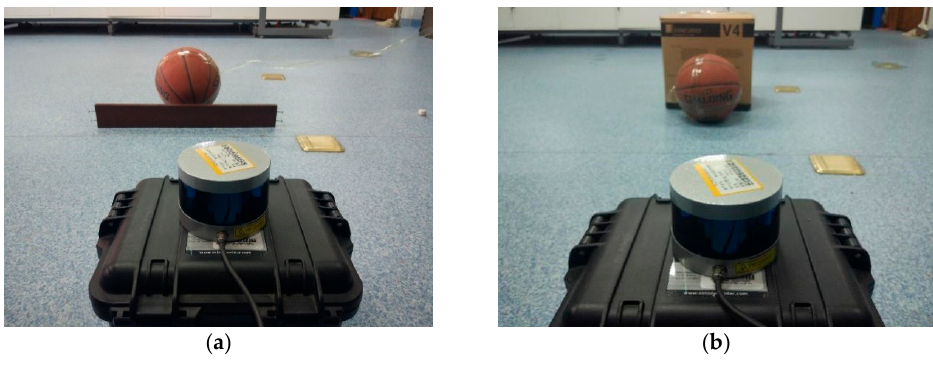
Figure 11. Experimental scenes: ( a ) Occlusion scene; ( b ) Obstacle scene.